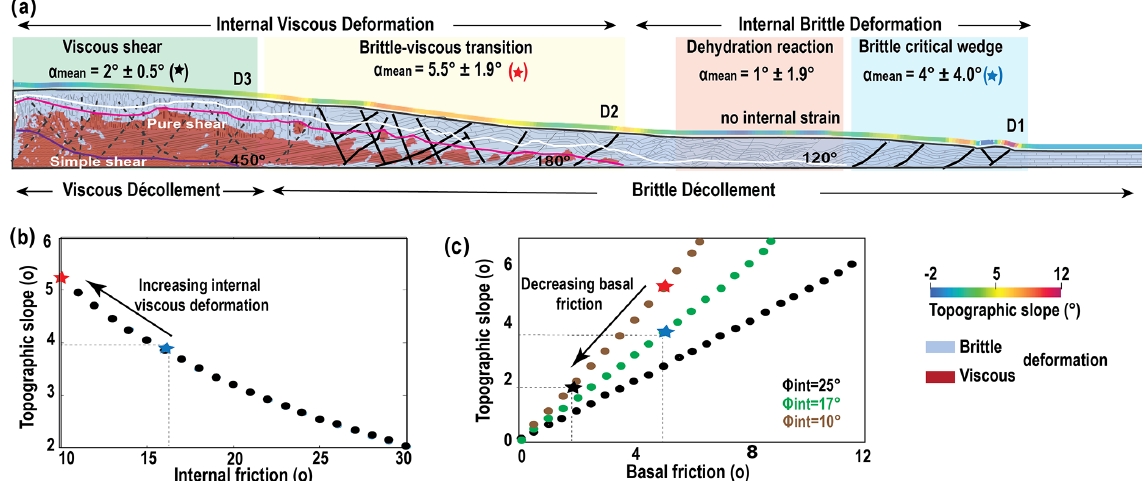
Figure 9. (a) Proposed model for the mature brittle–ductile wedge which forms three distinct segments; pure brittle wedge with a rather constant slope predicted by the CTT at the front (blue star), low but non-zero topographic slope close to the backstop corresponds to viscous deformation (black star), and larger topographic slope in between these segments as a result of the brittle–ductile transition (red star and yellow rectangle). (b) Topographic slope versus internal friction for φ basal = 5 ◦ . (c) Basal friction versus topographic slope for φ int of 10, 17, and 25 ◦